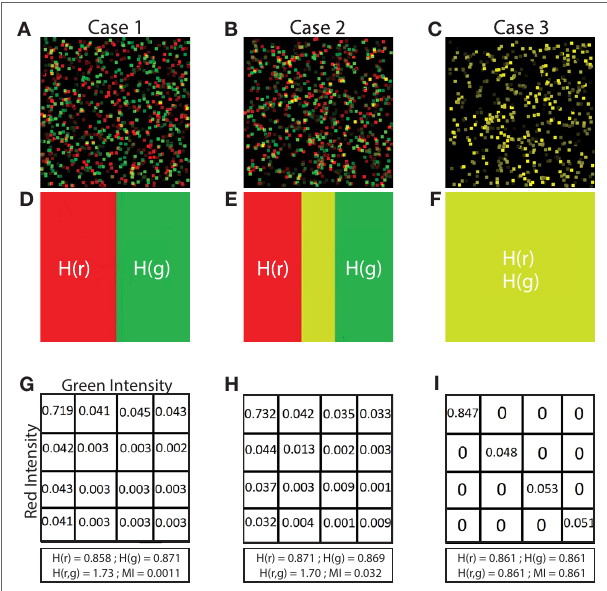
FigUre 1 | Notched boxplots displaying PCC (a) and NMI (B) values for T:DC, T:FRC, and T:BV images. Data include 6 T:DC image z-stacks (2 experiments on 2 different days, 2 mice, 4 lymph nodes), 12 T:FRC image z-stacks (3 experiments on 3 different days, 6 lymph nodes), 4 T:BV image z-stacks (2 mice on 2 different days, 3 lymph nodes). Black dots indicate the mean. Median T:DC PCC value = 0.1922, median T:FRCs PCC value = 0.3810, median T:BV PCC value = 0.2447. Mann–Whitney p values for T:DC–T:FRCs < e − 4, T:DC–T:BV = 0.0293, and T:FRC-T:BV < e − 4. Median T:DC NMI value = 0.0101, median T:FRC NMI value = 0.0798, and median T:BV NMI value = 0.1355. Mann–Whitney p values for T:DC–T:FRC, T:DC–T:BV, and T:FRC-T:BV comparisons < e −